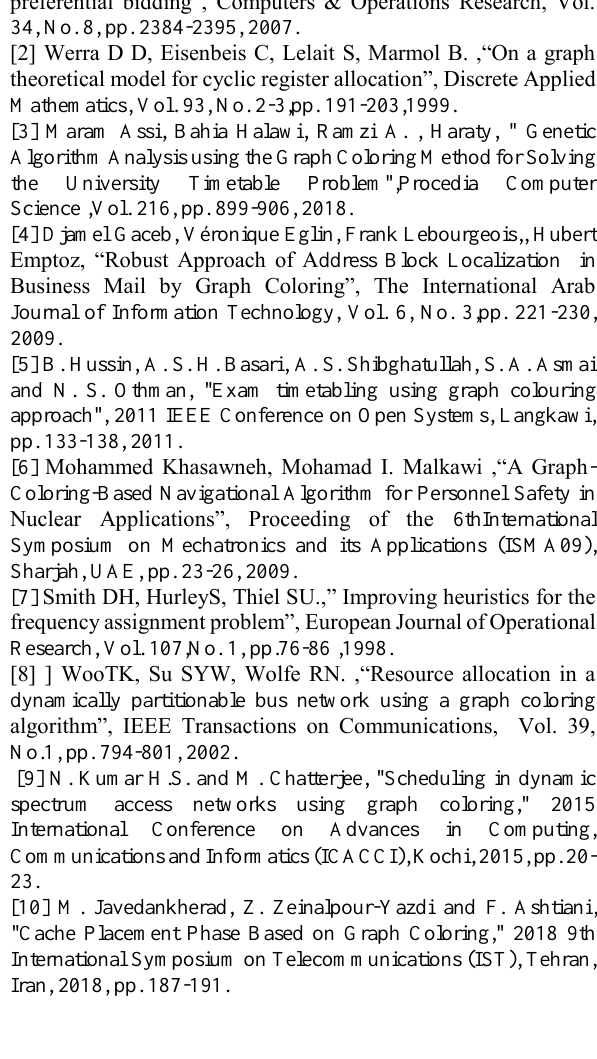
Algorithm Analysis using the Graph Coloring Method for